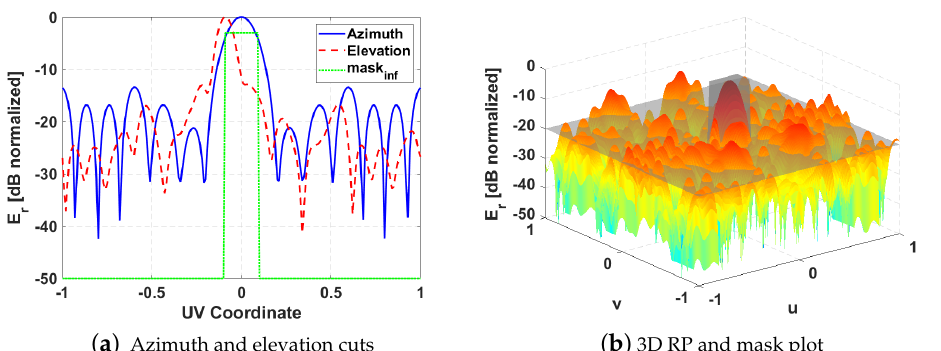
Figure 7. Results of the proposed optimization method launched in Matlab for reflectarray design at 11